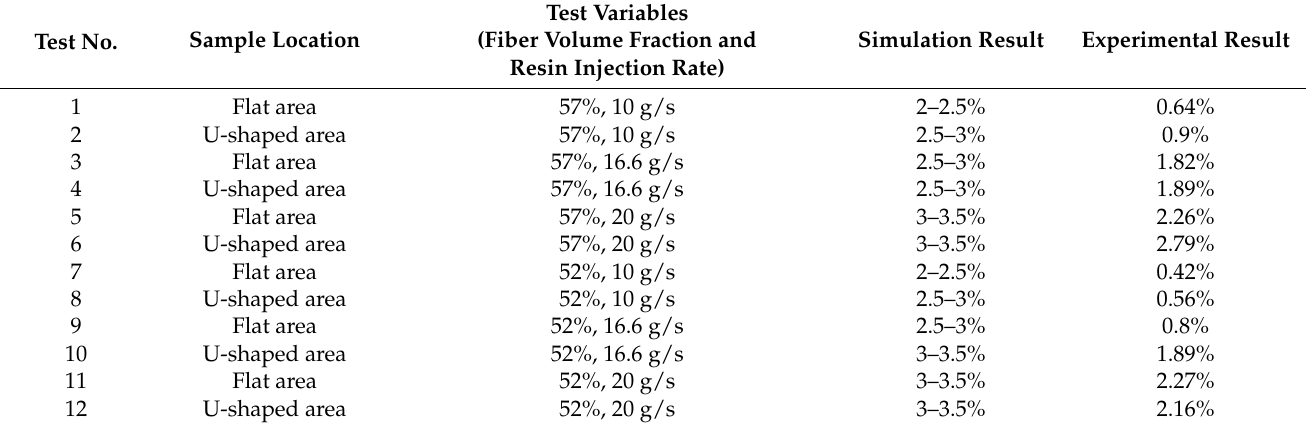
Figure 7. ( a ) Schematic of scanned layer; ( b ) Representative ultrasonic scanning results showing void content. Table 3. Comparison of void content between simulation and experimental results.